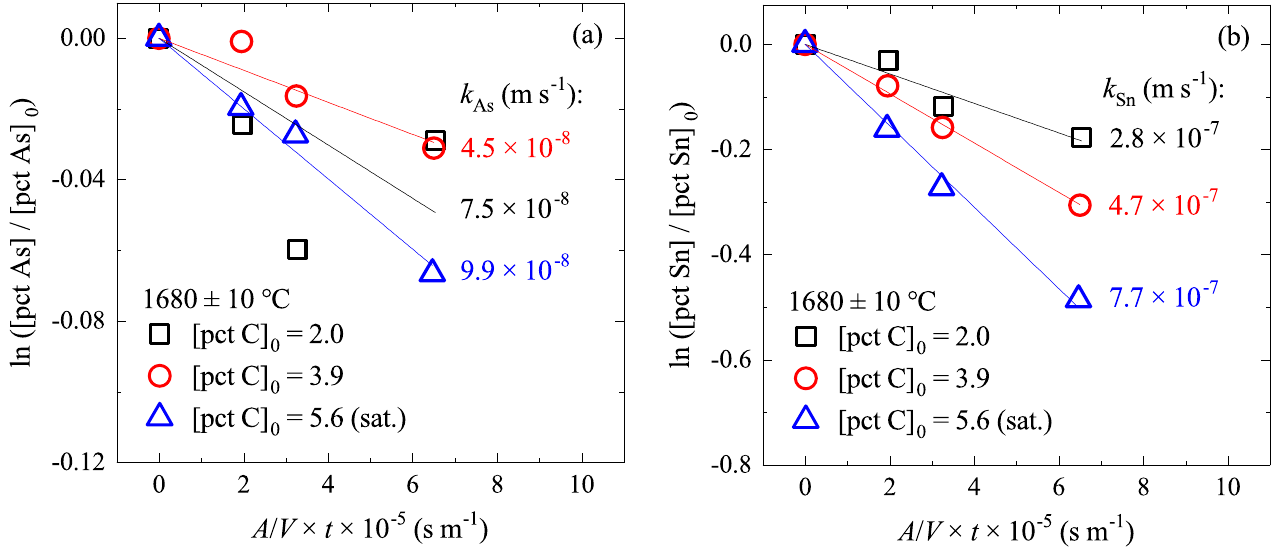
Figure 2. Changes of ( a ) [pct As]/[pct As] 0 and ( b ) [pct Sn]/[pct Sn] 0 in Fe–C–As–Sn alloys with various [pct C] 0 at 1680 ± 10 ◦ C. (color